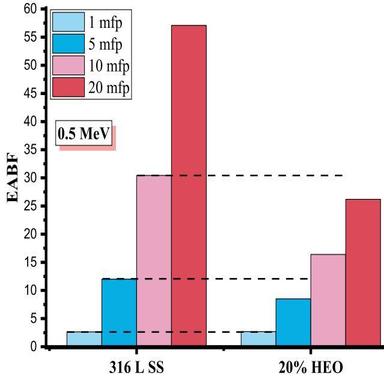
Change of (a) EABFs and (b) EBFs with several penetration depths for 316 L SS and 20 % HEO samples at fixed 0.5 MeV photon energy.